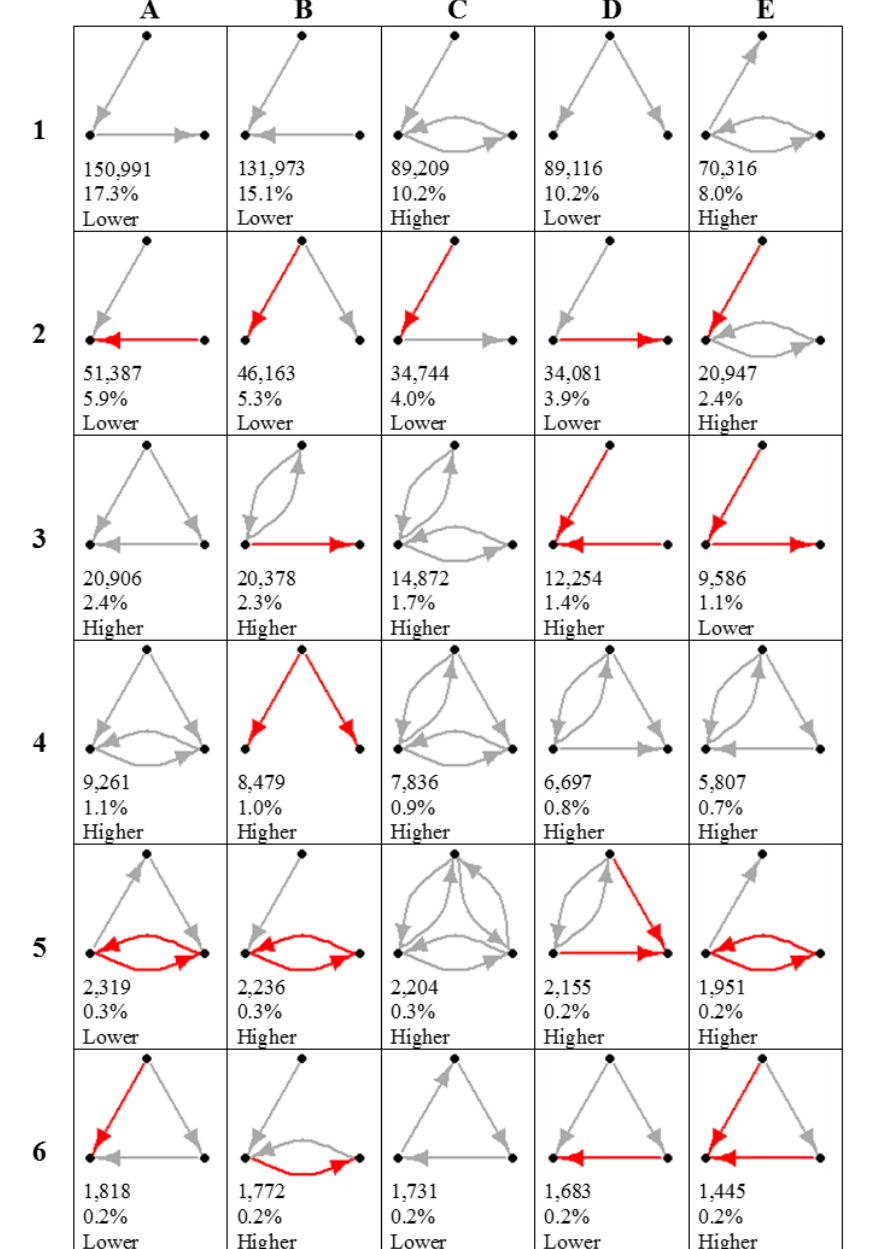
Figure 4: Illustration of the top 30 empirically observed connected triads. This shows the 30 most numerous of the 132 possible directed connected triads (those without a completely disconnected node) across all villages ordered by the total number of observations. Gray ties represent friendship; red ties represent antagonism. Total counts are shown below each triad as well as their percentage representation among connected triads. Comparison to simulated random networks (N = 1,000) is shown at the bottom of each cell; “higher” means that the triad appears in villages more often, and “lower” means that the triad appears in villages less often than is due to chance alone ( p < 0.005). Letters A through E (top row) and numbers 1 through 6 (left column) are guides for easier cell identification. The full Heterogenous Triad Census is shown in the online supplement (Table